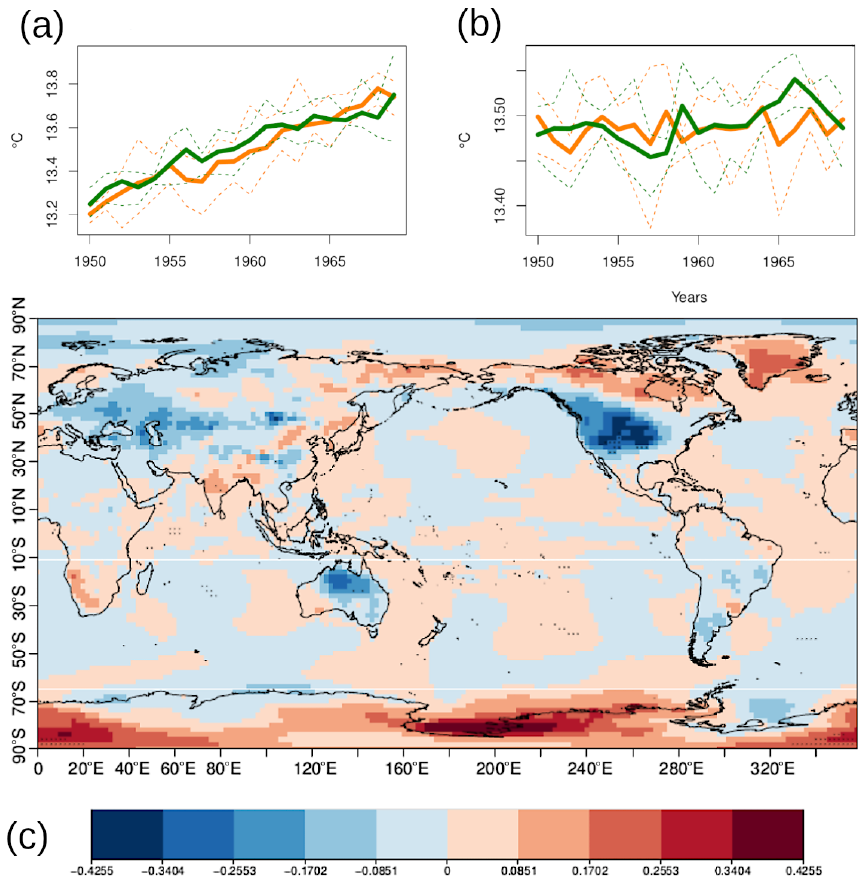
Figure 2. Comparison between Rhino and CCA platforms for AMIP experiments and historical CMIP experiments for 2m temperature (t2m). Panels (a) and (b) show mean (solid line) as well as maximum and minimum values (dashed lines) between the ensemble members for AMIP (a) and CMIP (b) experiments, respectively. Green and orange refer to Rhino and CCA platforms, respectively. Panel (c) shows the t2m difference between the CMIP ensemble runs. Black dotted regions indicate statistical significance according to the Kolmogorov–Smirnov test (1.2% of grid points show a significant difference in this